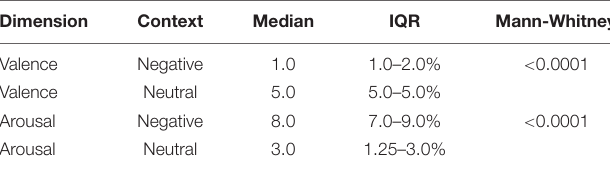
TABLE 2 | Median and interquartile range (IQR) of valence and arousal of each context.